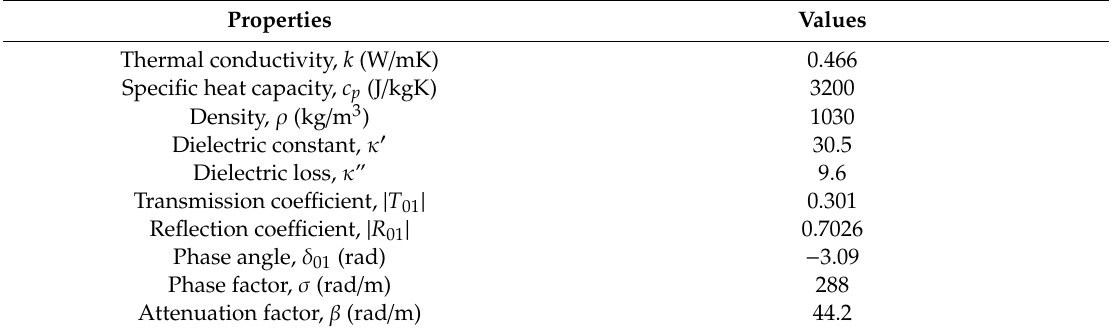
Table 1. Thermal and dielectric properties of cylindrical beef ( f = 2450 MHz) [21,22]. Properties